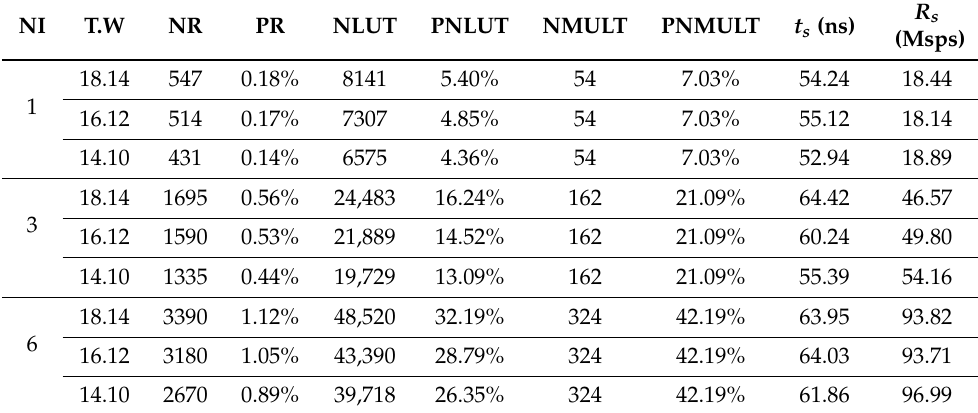
Table 5. Synthesis results regarding the hardware area occupation, processing time, and throughput for the MLP prediction technique, varying NI and T.W.